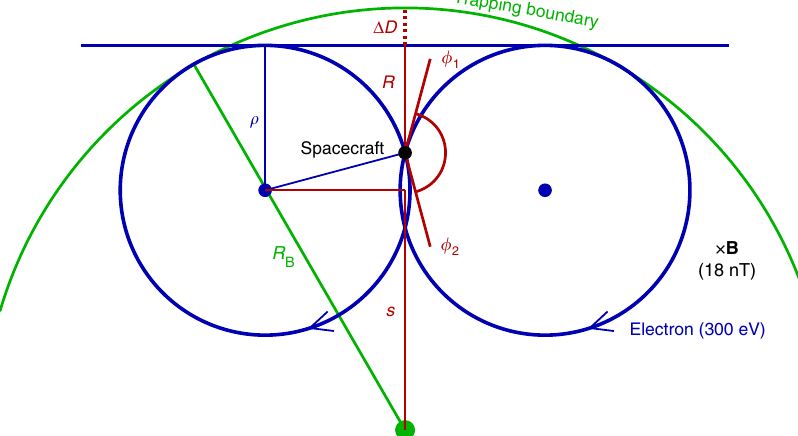
Fig. 8 The underestimation of the technique if the actual boundary curves outward. Δ D is the underestimation, ρ is the particle gyro-radius, R B is the boundary curvature radius, R is the sounding distance, and ϕ 1 and ϕ 2 are critical angles derived from the sounding into account, the uncertainty is given by: the time resolution. A supremum of Δ R is evaluated to be 2.2km in the ESMC event discussed in this paper.